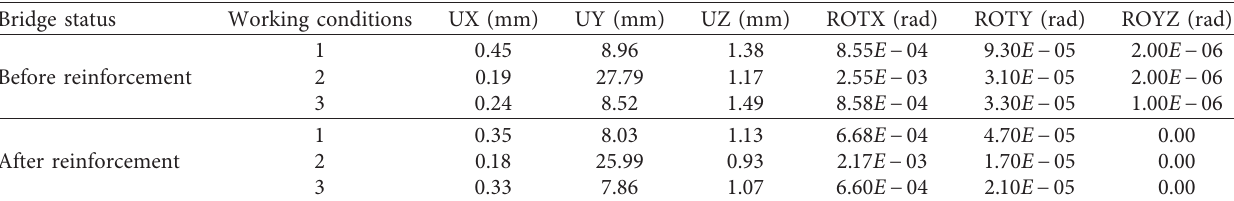
Table 10: Comparison of peak values of displacement at the mid-span position of bridge decks before and after reinforcement. Bridge status Before